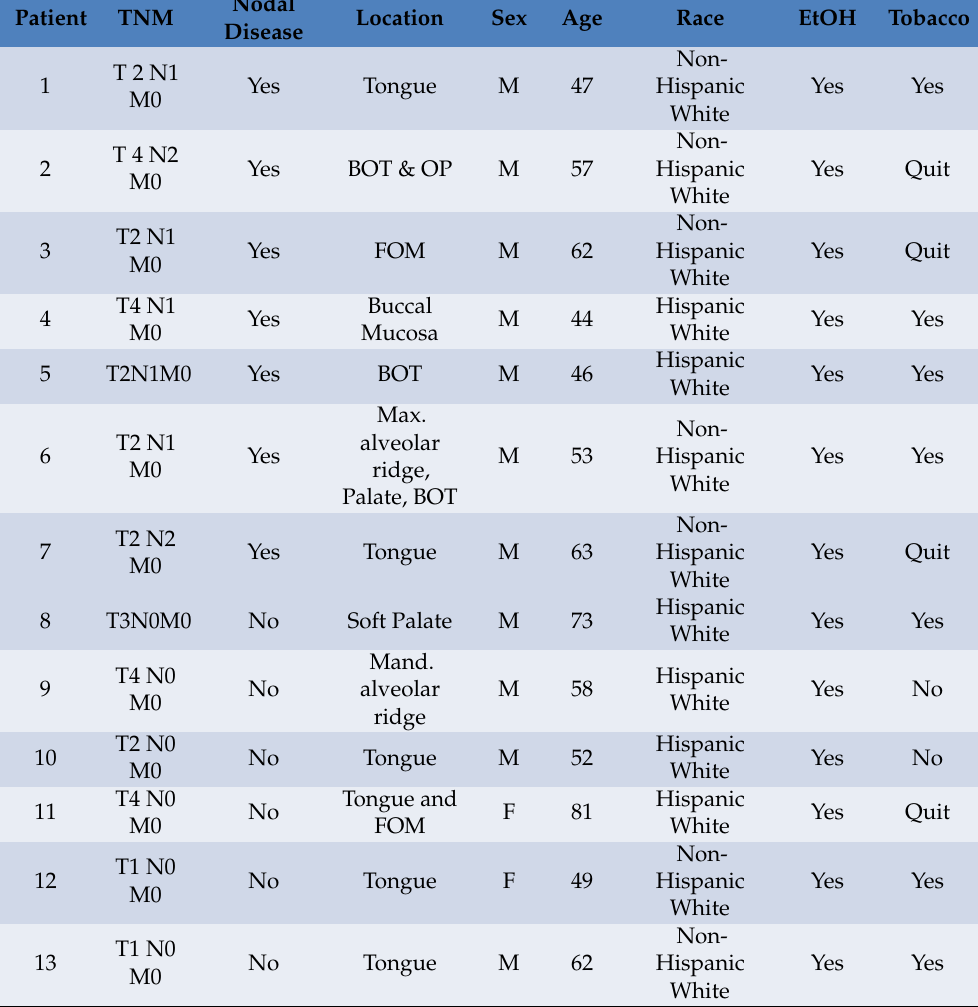
Table 1. Patient Demographics, Tumor Staging, EtOH, and Cigarette Tobacco Usage. Patient TNM